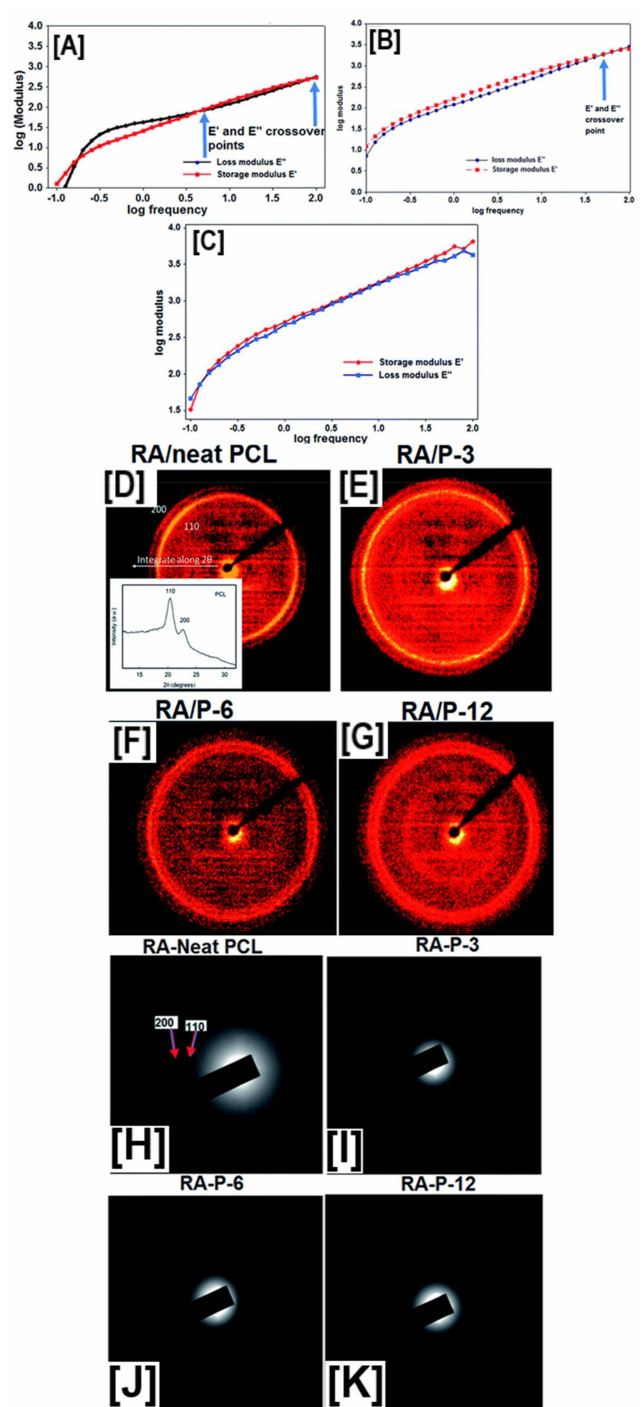
Figure 8. Establishing structure property relationships between pseudorotaxane (PpR) solution rheology and the resultant molecular arrangement of PpR in the nanofibers. Solution rheology of neat PCL solutions at higher concentrations (12%) showed low modulus values (elastic and loss) with multiple cross-over points, typical of viscoelastic material. On the other hand, PpR solutions showed frequent cross-over points, indicating a Rouse–Zimm effect ( A – C ). However, both 2D-wide angle X-ray diffraction ( D – G ) and selected area electron diffraction analyses ( H – K ) showed the presence of crystalline domains in both randomly aligned, as well as aligned PCL nanofibers, while no such peaks were evidently observed in PpR nanofibers. Images adapted and reproduced with permission from [97]. Copyright The Royal Society of America